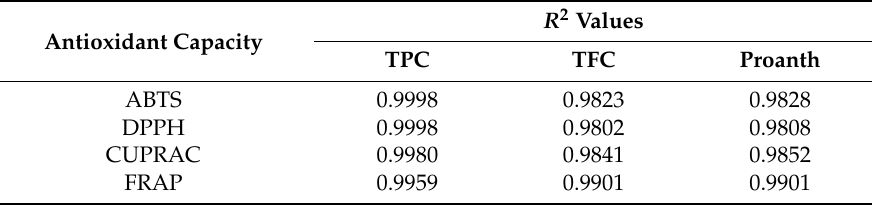
Table 4. Correlations between phenolic compounds, flavonoids, proanthocyanidins and antioxidant